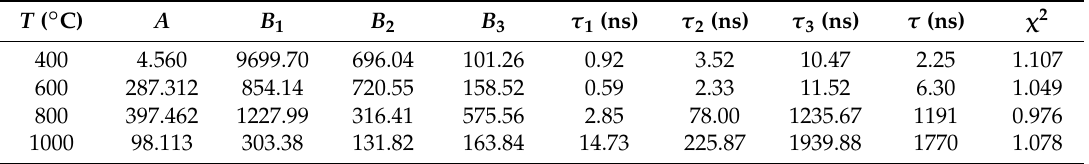
Table 3. Fitting parameters of the time-resolved PL spectra of Eu-doped ZnWO 4 precursors subjected to annealing at different temperatures. The detection wavelength is 480